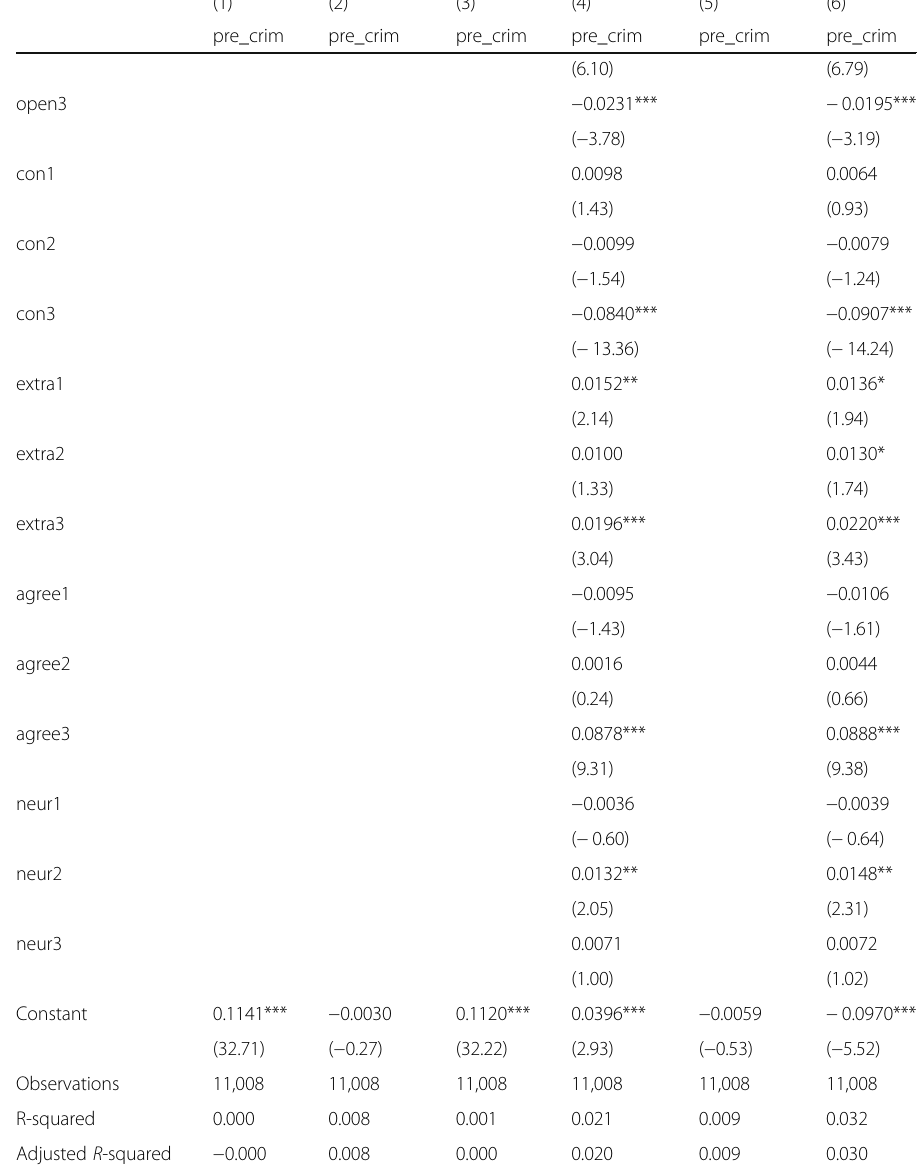
Table 14 Question-level correlates of criminal background in hired population (all positions)